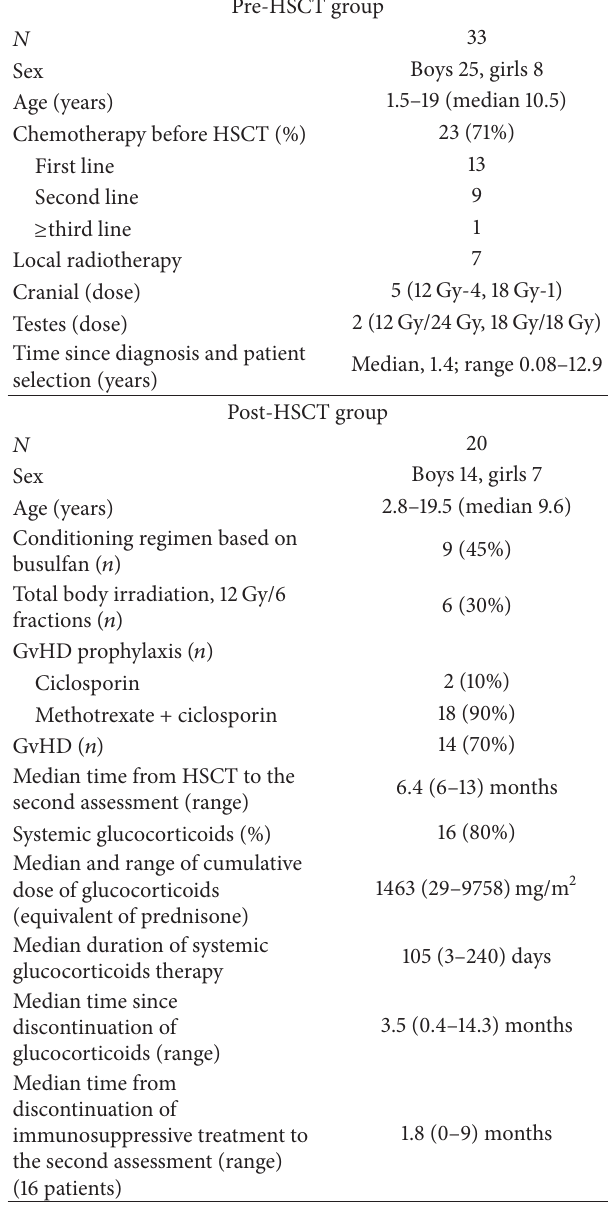
Table 1. Characteristics of children referred for HSCT are presented in Table